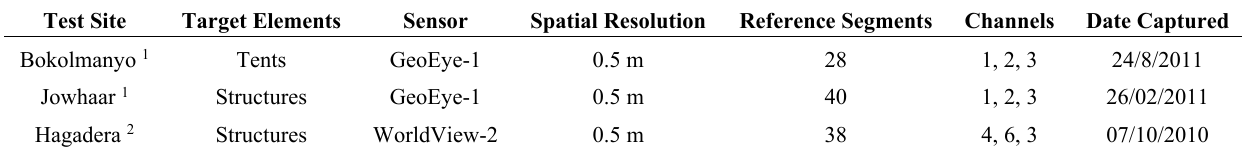
Figure 7. The three image analysis tasks defined for evaluating the method variants, namely, thematically correctly segmenting tents in the Bokolmanyo problem ( a ) and metal-roofed structures in the Jowhaar ( b ) and Hagadera ( c ) problems. Table 3. The datasets, with accompanying metadata, used for evaluating the method variants (adapted from